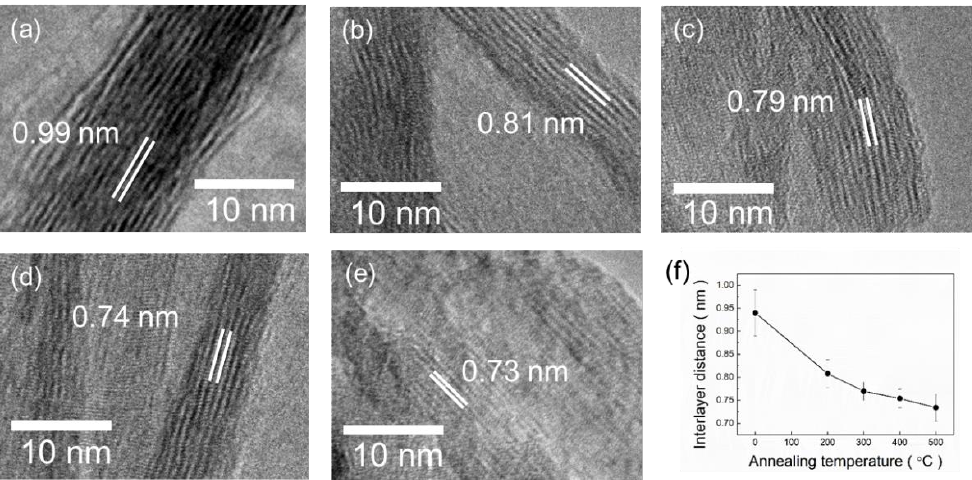
Figure 5. Transmission electron microscopy (TEM) images of ( a ) as-synthesized PTNTs and ( b – e ) annealed PTNTs at 200, 300, 400, and 500 °C for 1 h, respectively. ( f ) Variation in the interlayer distance for annealing temperatures taken from 30 zones, respectively.